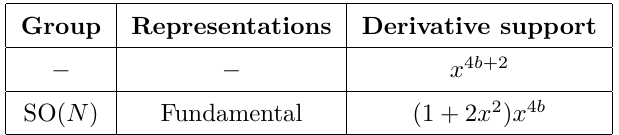
Table 2 . Bulk contact terms ( D = 2 ): fermions with and without global symmetry S-matrix Lagrangian